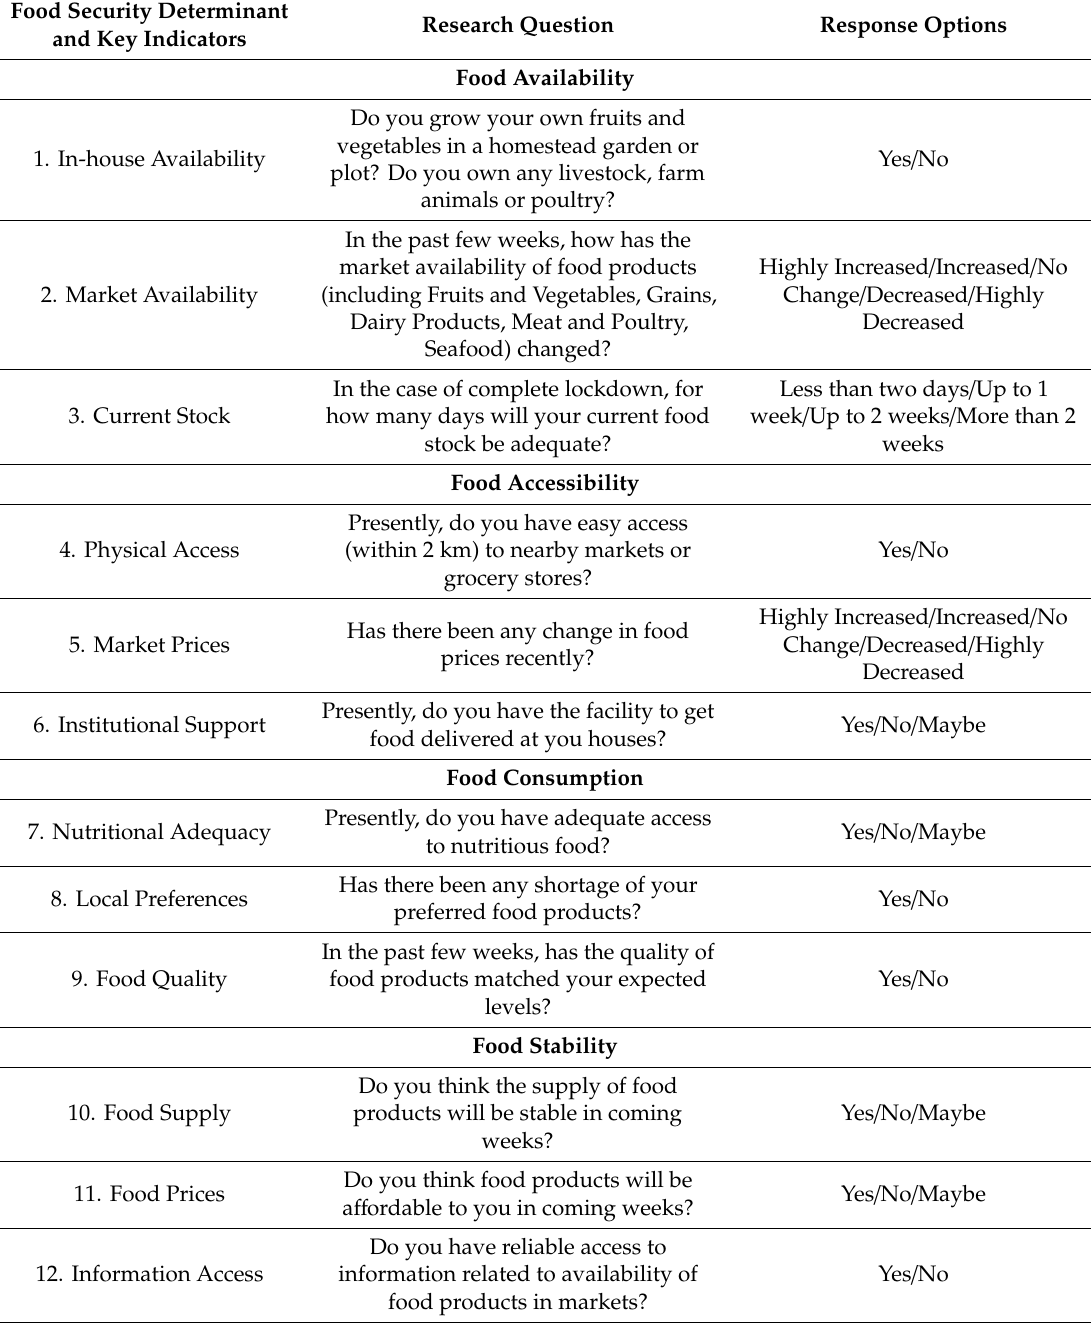
Table 2. Indicators for assessing the perceived household food security under COVID-19